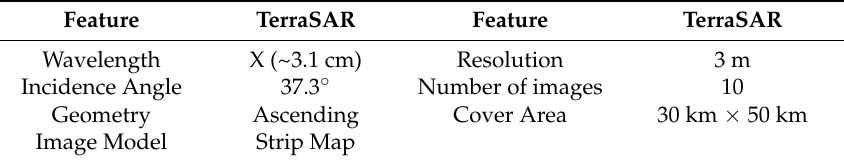
Table 2. Main features of the available SAR dataset in the AOI of